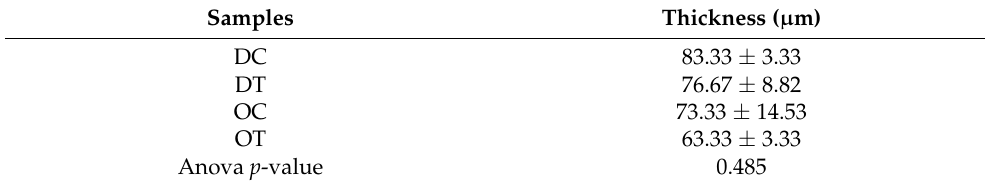
Table 3. Bran thickness for control and plasma treated-wheat seeds.